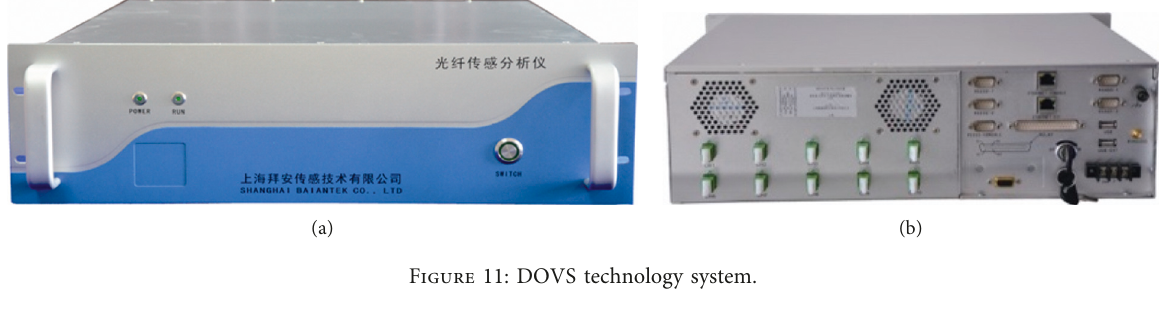
Figure 11: DOVS technology system.